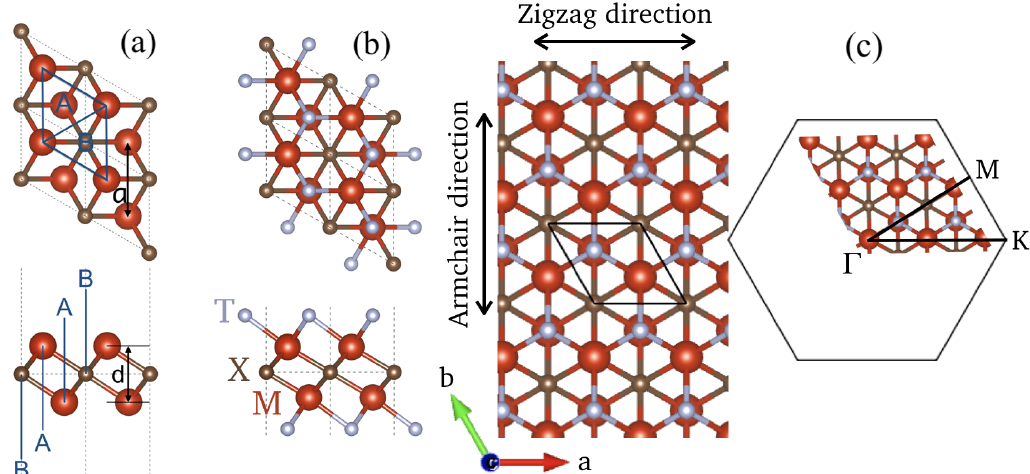
Figure 7. Atomic structure of ( a ) pristine V 2 C and ( b ) terminated V 2 CT 2 with MD2, and ( c ) high-symmetry armchair and zigzag directions in both real and reciprocal space.